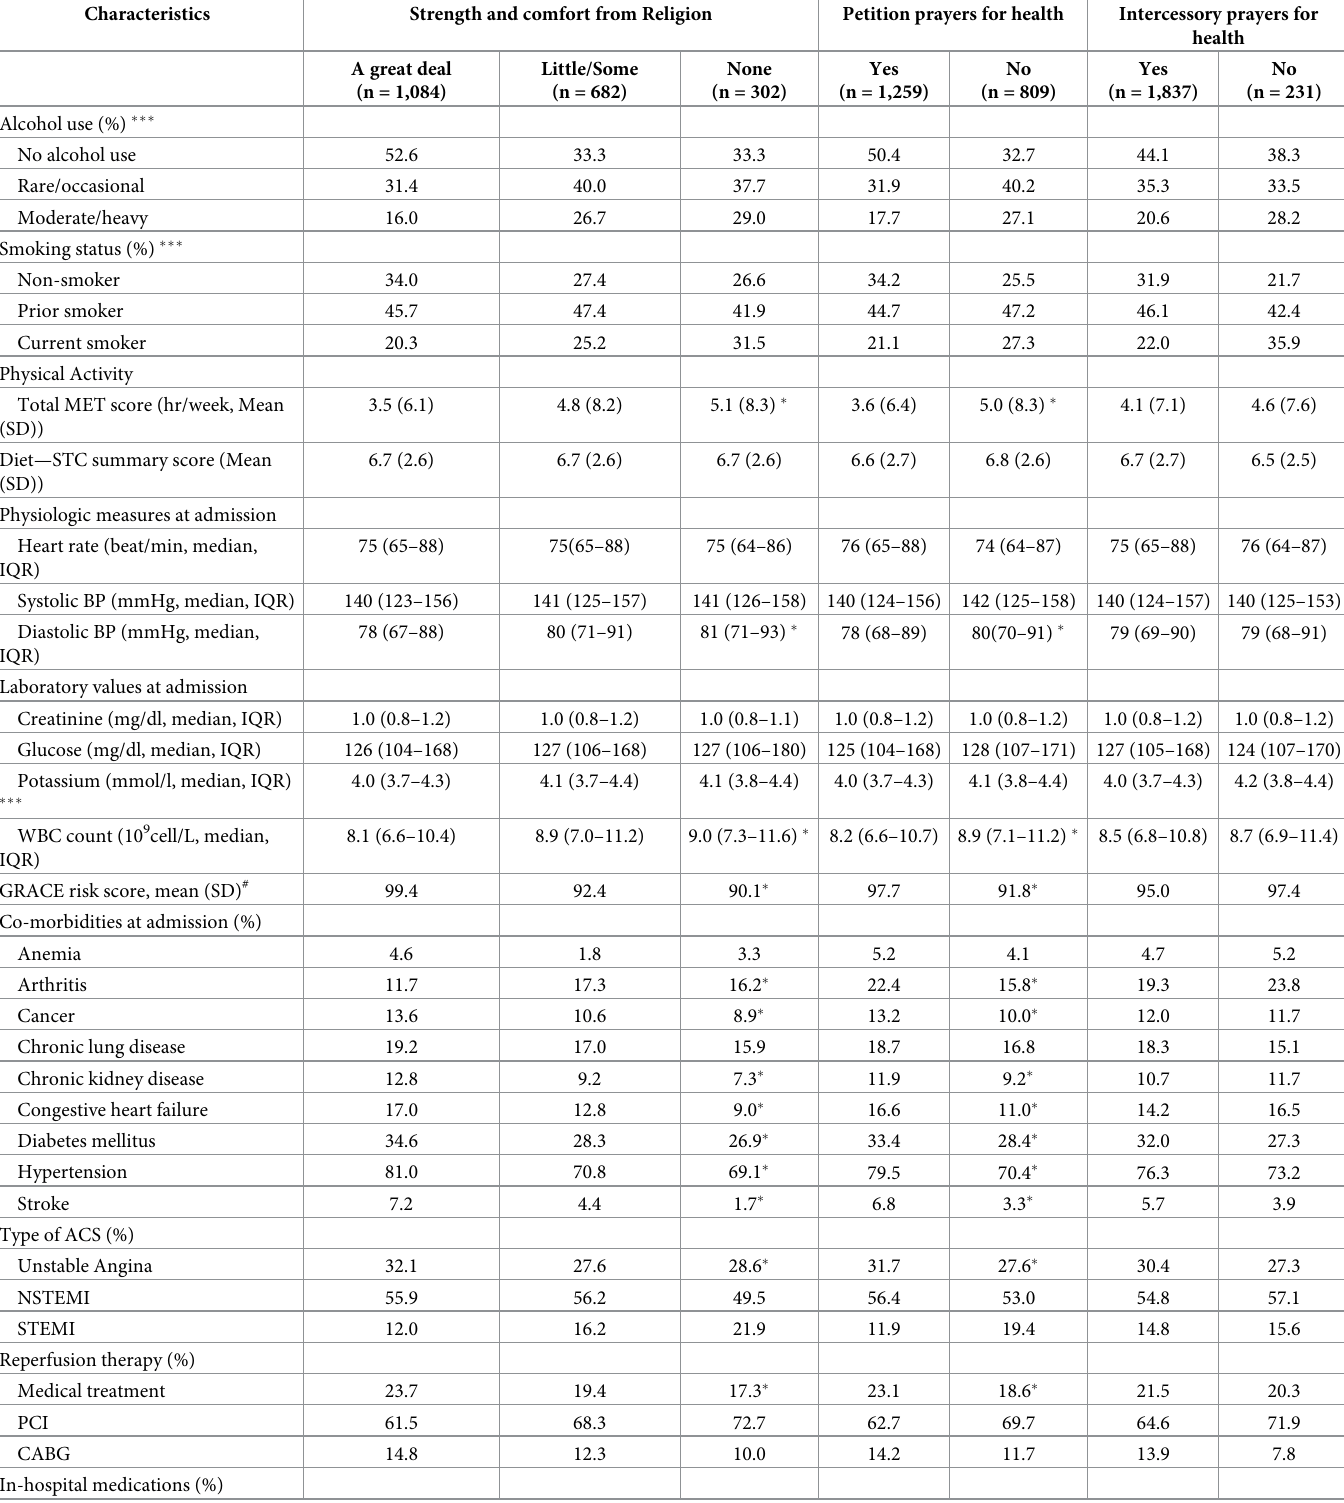
Table 2. Baseline behavioral and clinical characteristics of hospital survivors of an acute coronary syndrome according to measures of religiosity.